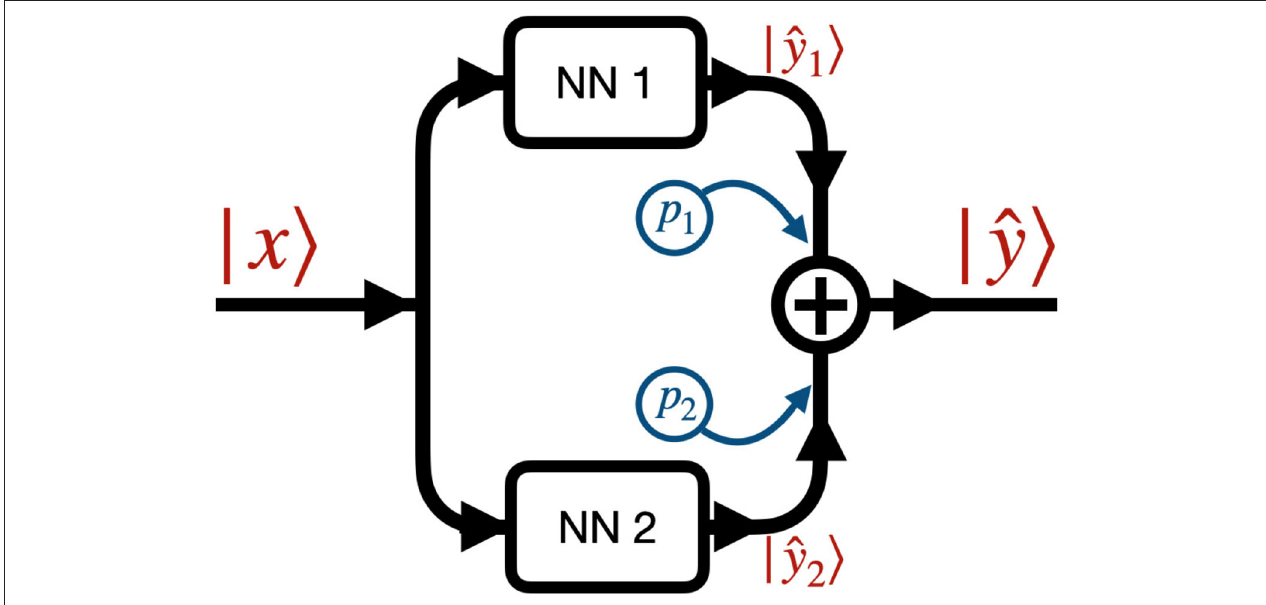
x passes through NN 1 (see Figure 3A ) and NN 2 (see Figure 3B ), generating the two outputs | i